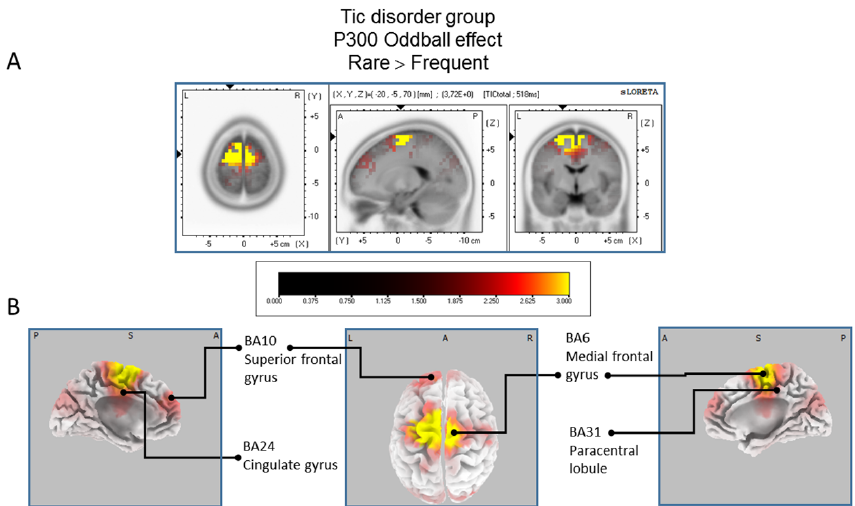
Figure 2. Results of the tic disorder patients based on the standardized low-resolution brain electrotomography (sLORETA) current source density localization of the oddball effect (contrast: “Rare” > ”Frequent”) in the peak activation of the P300 component within a 300–550 ms time window. Images have been obtained after statistical non-parametric mapping (SnPM) and co-registration to the stereotaxic Talairach space based on the Co-Planar Stereotaxic Atlas of the Human Brain [83] and the probabilistic MNI-152 template [81]. Activated voxels are indicated by yellowish and reddish colors (after correction for multiple comparisons ( p < 0.01 and p < 0.05, respectively)). ( A ) The peak of highest cortical activity has been found in parts of the superior frontal gyrus (BA10), the medial frontal gyrus (BA6), the paracentral lobule (BA31), and the cingulate gyrus (BA24). ( B ) A shifted transverse and sagittal view of the left and the right hemisphere, showing cortical activations on the three-dimensionally rendered Colin27 template [89] L, left; R, right; A, anterior; P, posterior; MNI, Montreal Neurological Institute; X, Y, Z, corresponding MNI coordinates; BA, Brodmann Area.